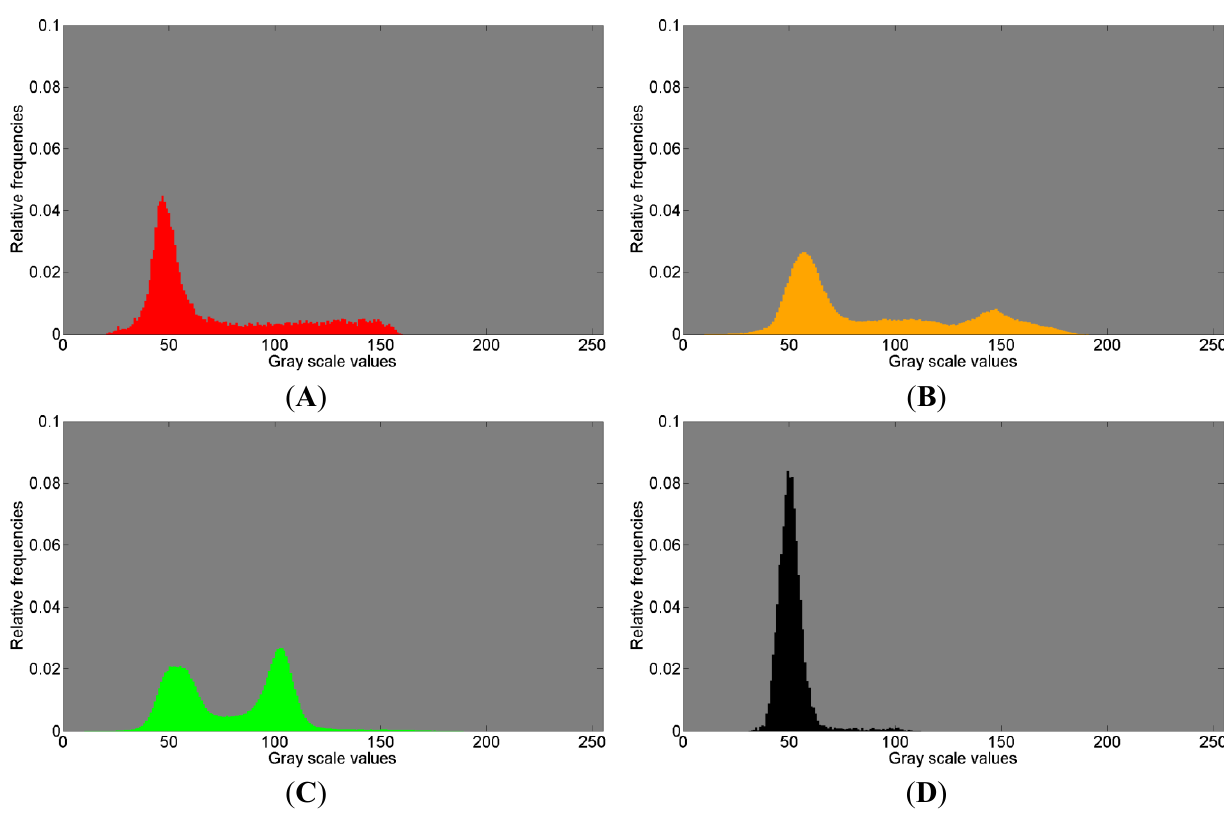
Figure 9. Histogram of gray scale values for ( A ) red; ( B ) orange; ( C ) green; ( D ) black,